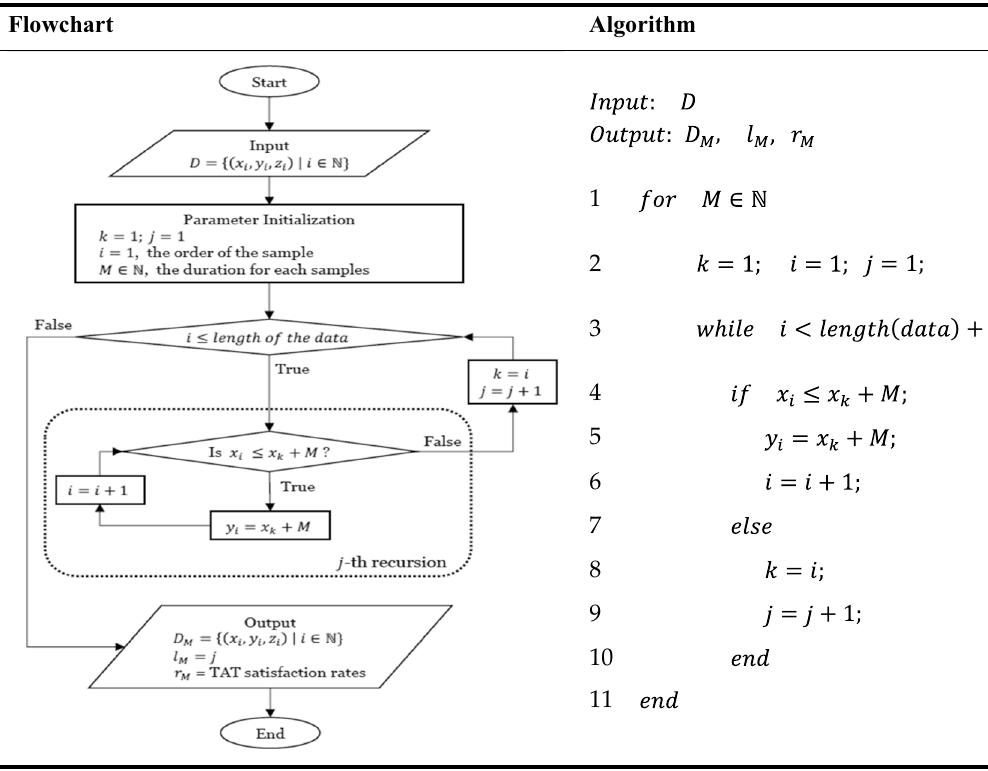
Figure 3. Flowchart and proposed algorithm for task switching.